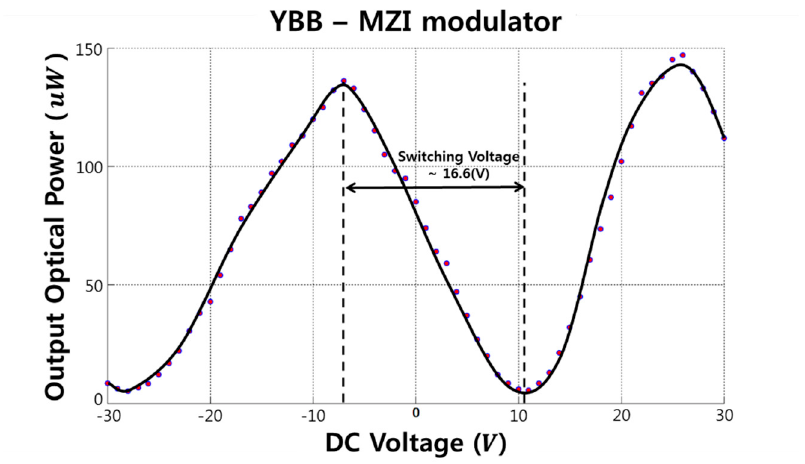
Figure 5. Measured optical output power intensity versus the applied DC voltage.